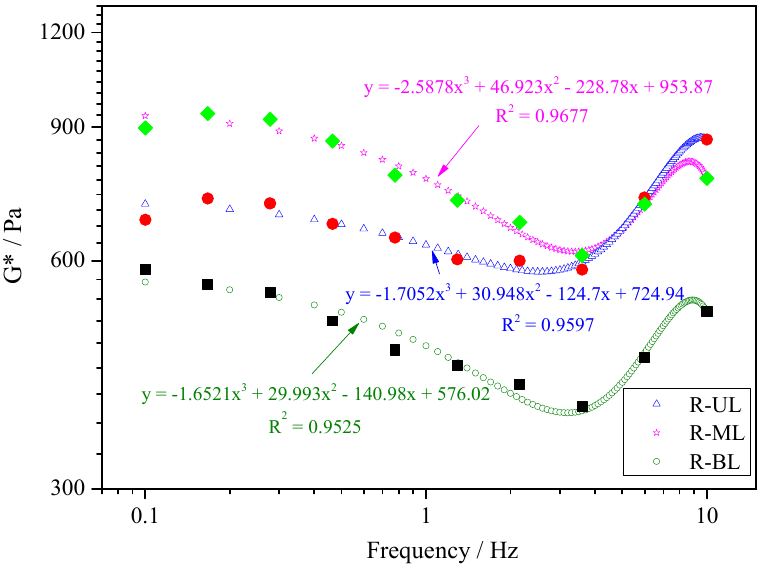
Figure 11. Complex shear modulus of bitumen from R-UL, R-M, and R-BL. 251